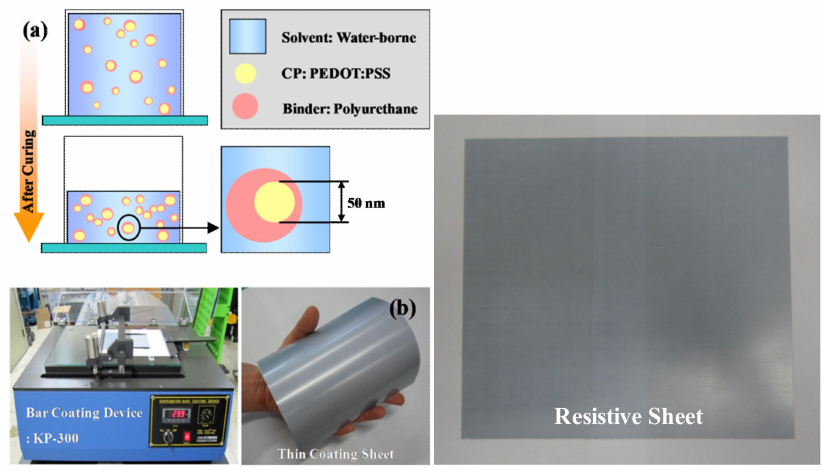
Figure 12. Fabrication of the thin resistive sheet: ( a ) thin film coating process ( b ) resistive sheet.